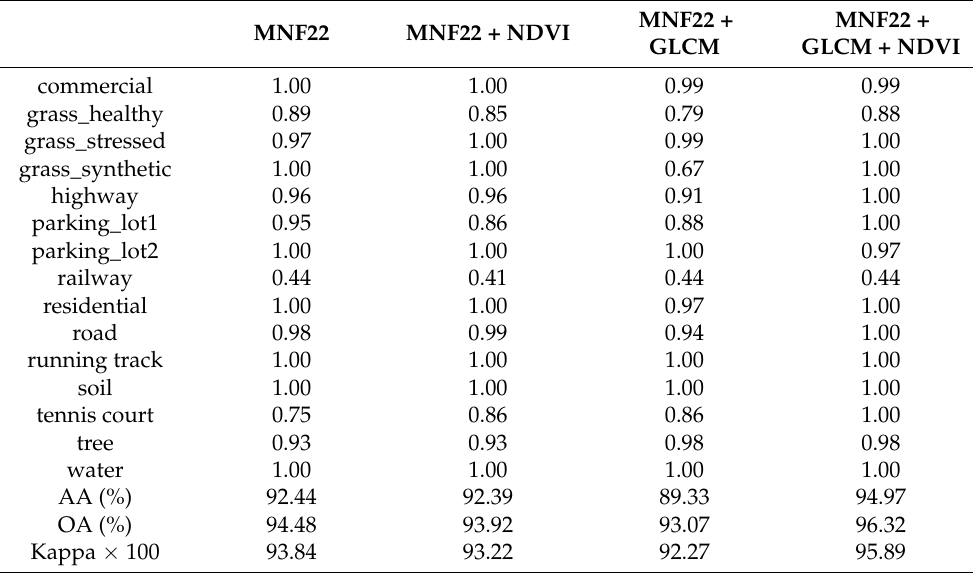
Table 8. Comparison of the performance of different hyperspectral parameters on Houston dataset (input size =